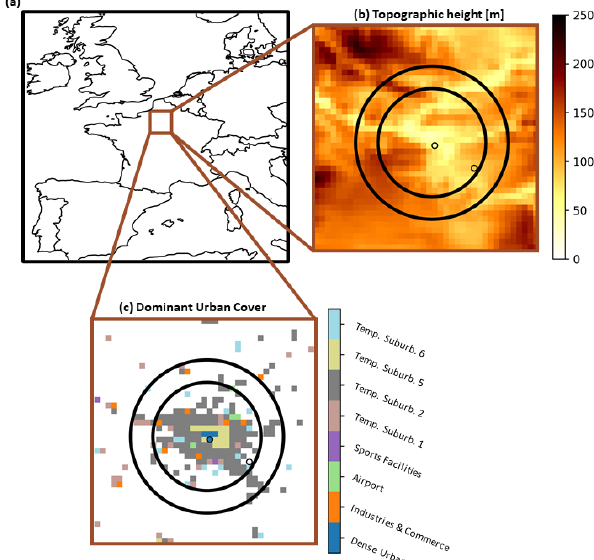
Figure 1. Study domain identified by the brown square in panel (a) . Panel (b) shows a magnification of the simulation domain, with the color shading representing topographic height. Panel (c) shows a magnification of the simulation domain, with the color scheme rep- resenting the dominant urban classes for grid boxes where urban fraction exceeds 0.1 (grid boxes where urban fraction is below 0.1 are white). The large black circles in panels (b) and (c) identify the inner and outer rings for computing the SUHI (see Sect. 2.3). The circular markers in panels (b) and (c) identify the station locations for computing the UHI (see Sect.